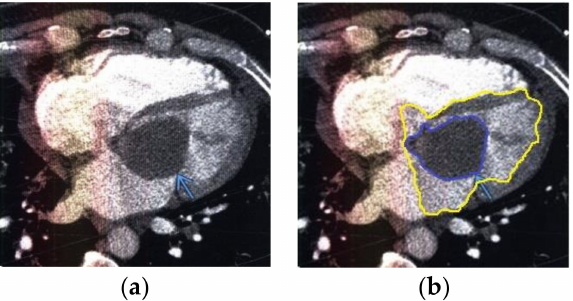
Figure 9. Heart MRI: ( a ) image with white noise and ( b ) denoised image with contrast enhancement of the myxoma in the left